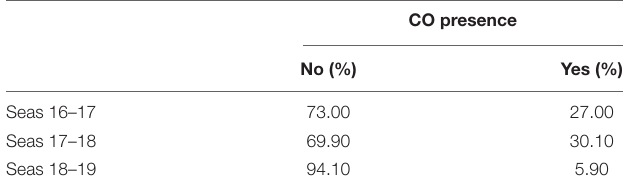
TABLE 6 | Contingency table: Season * Presence of